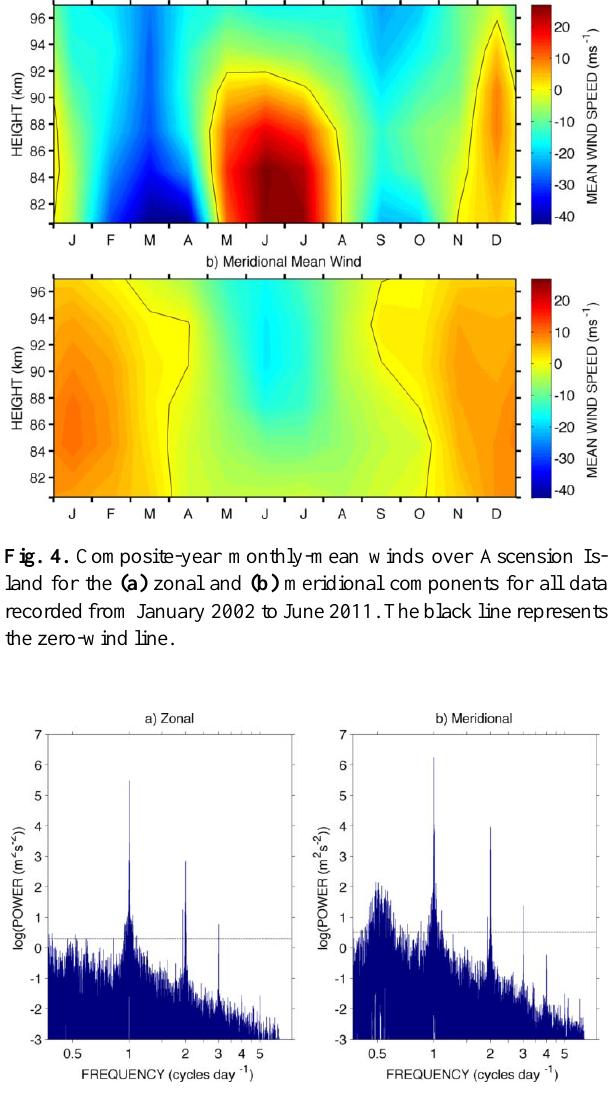
Fig. 5. Lomb–Scargle periodograms of the (a) zonal and (b) merid- ional wind components at heights near 94km for the entire set of Ascension Island data (2002–2011). The horizontal dashed lines show the 95% confidence limit. Note that the strong signal present at 1.93 cycles/day is likely to arise from the lunar semidiurnal